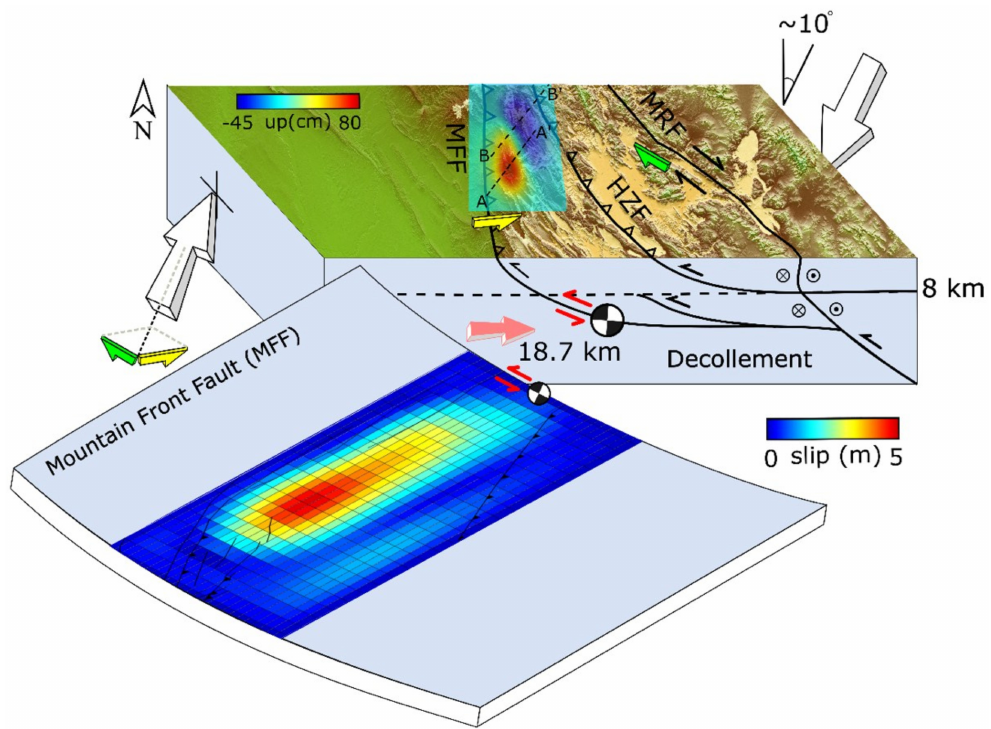
Figure 7. Block diagram illustrating how oblique convergence is accommodated in the northern portion of the Zagros collision zone. This model is supported by the slip distribution plane calculated in this study, as well as seismological (e.g., Reference [15]) and geological (e.g., Verges et al. 2011 [65]) observations. The white arrows show the N10 ◦ E direction of the Arabian plate convergence relative to the Eurasian plate. Solid black lines mark the major active faults in the region [66]. The geometries of the fault planes in the cross-section were extracted from our slip distribution plane aligned by the Main Frontal Fault (MFF) structure and the seismological model of Motaghi et al. (2017) [15]. Yellow and green arrows mark the convergence components accommodated by the MFF and Main Recent Fault (MRF), respectively. The beach balls show the cross-section view of the focal sphere, corresponding to the 2017 Sarpol-e Zahab earthquake. The dashed line marks the approximate bottom of the sedimentary layer based on Verges et al. (2011) [65]. MFF—Main Frontal Fault; HZF—High Zagros Fault; MRF—Main Recent Fault. The dashed line marked by AA’ shows the location of the profile presented in Figure 8. Line BB’ indicates the location of the seismic profile presented by Tavani et al. (2018)